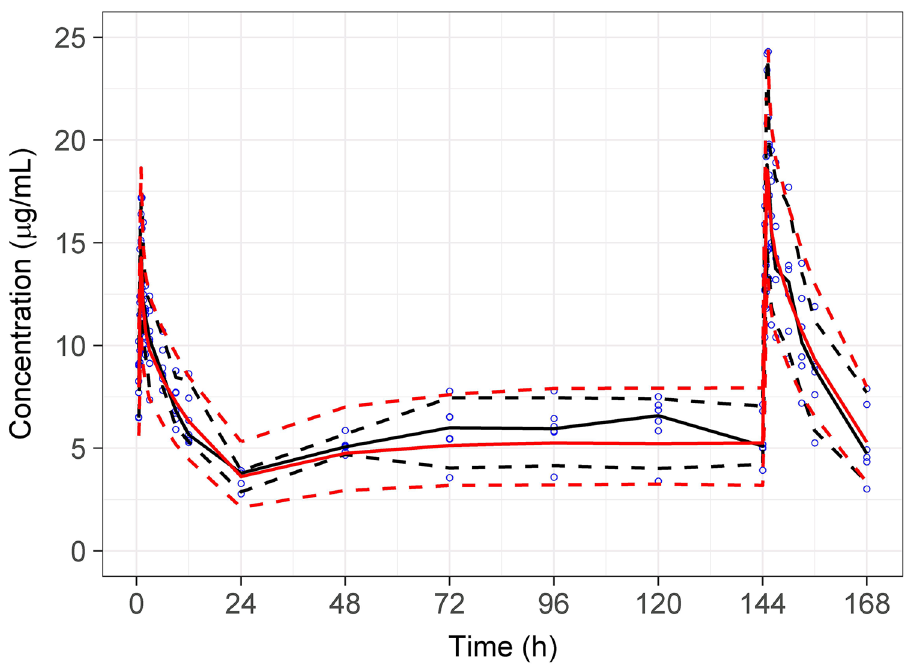
Fig 1. Visual predictive check plot for 1000 simulations of the final pharmacokinetic model and observed data. Solid lines are the medianand dashed lines represent the upper and lower confidence intervals of the observeddata (black) and predictionintervalsof the final model (red). Circles are the raw